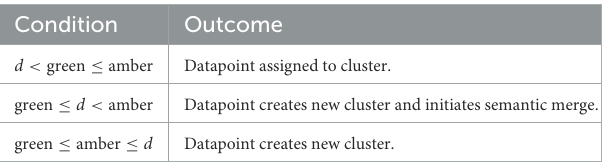
TABLE 2 Behavior of collage algorithm when a new datapoint